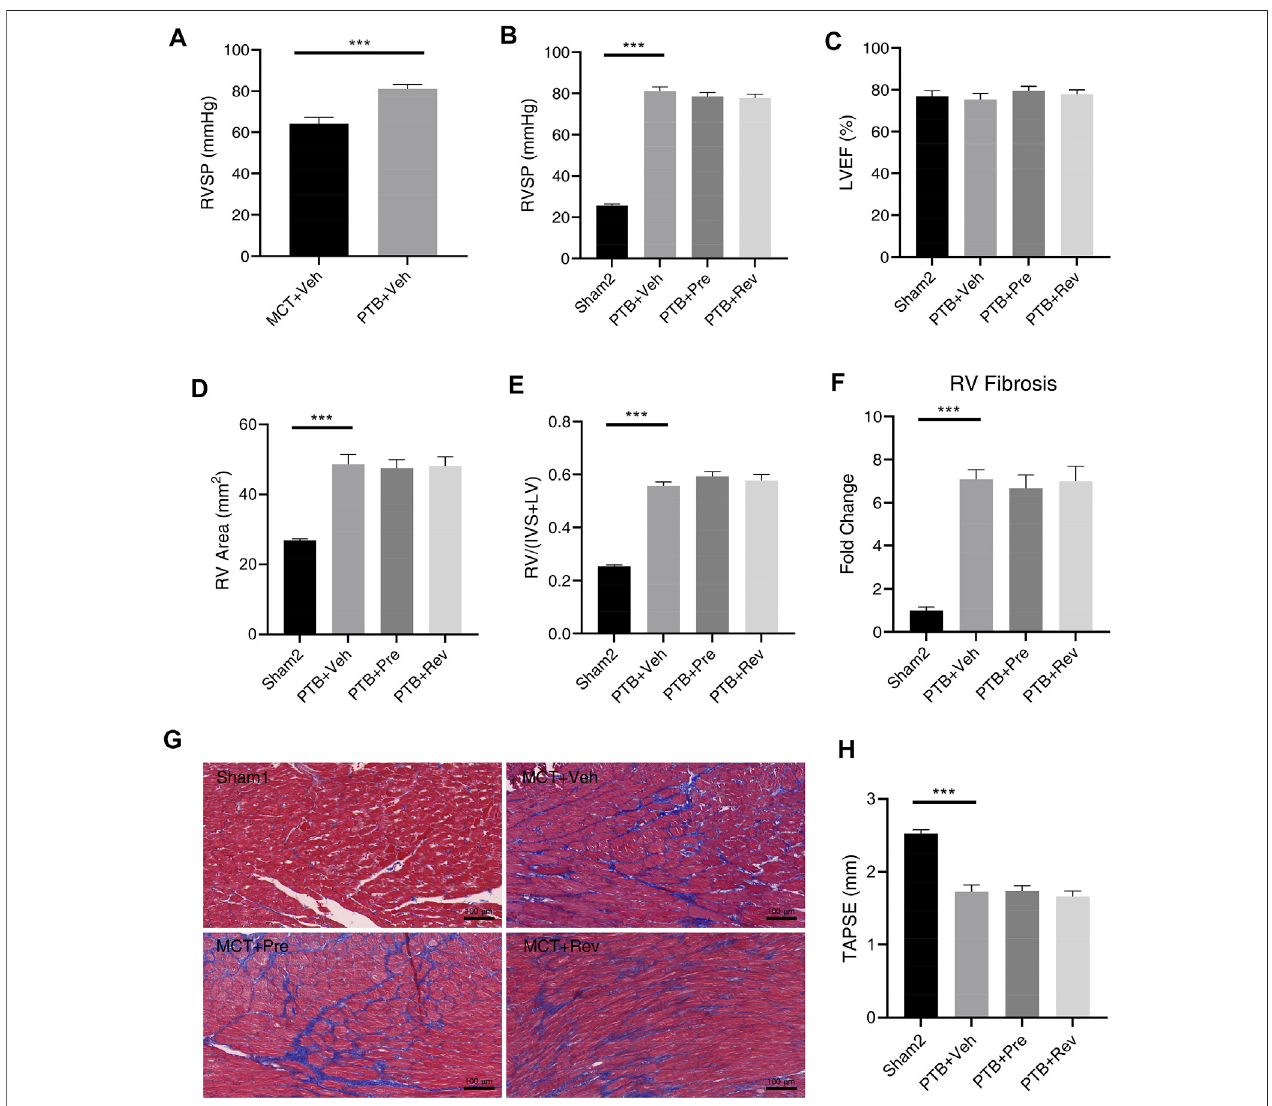
FIGURE 6 | Dapagli fl ozin could not attenuate RV remodeling or improve RV dysfunction in PTB rats. (A) RVSP fi ve weeks after MCT injection or four weeks after PTB surgery (n (cid:1) 10 for two groups); Quanti fi cation of RVSP (B) , LVEF (C) , RV area (D) , RV/(IVS + LV) (E) , RV fi brosis (F) , and TAPSE (H) ; (G) Representative images of Masson staining in the cardiac sections. (*** p < 0.001; n (cid:1) 6 for Sham2, n (cid:1) 10 for PTB + vehicle, PTB + prevention, and PTB + reversal).